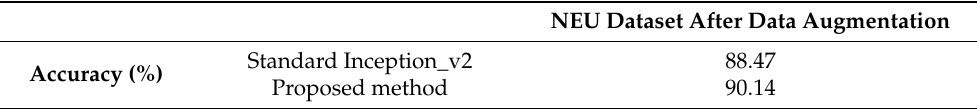
Table 3. The average classification accuracies of standard Inception_v2 and the proposed method with the NEU dataset after data